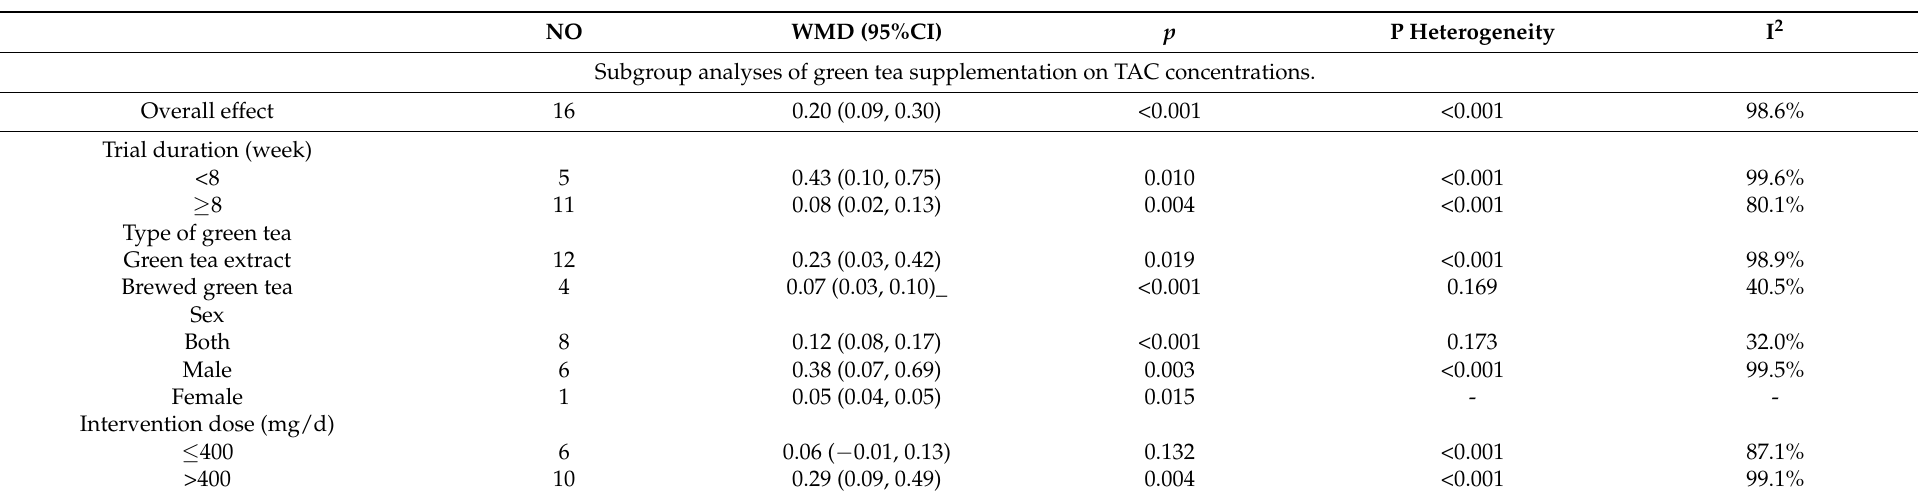
Table 3. Subgroup analyses of green tea supplementation on oxidative stress